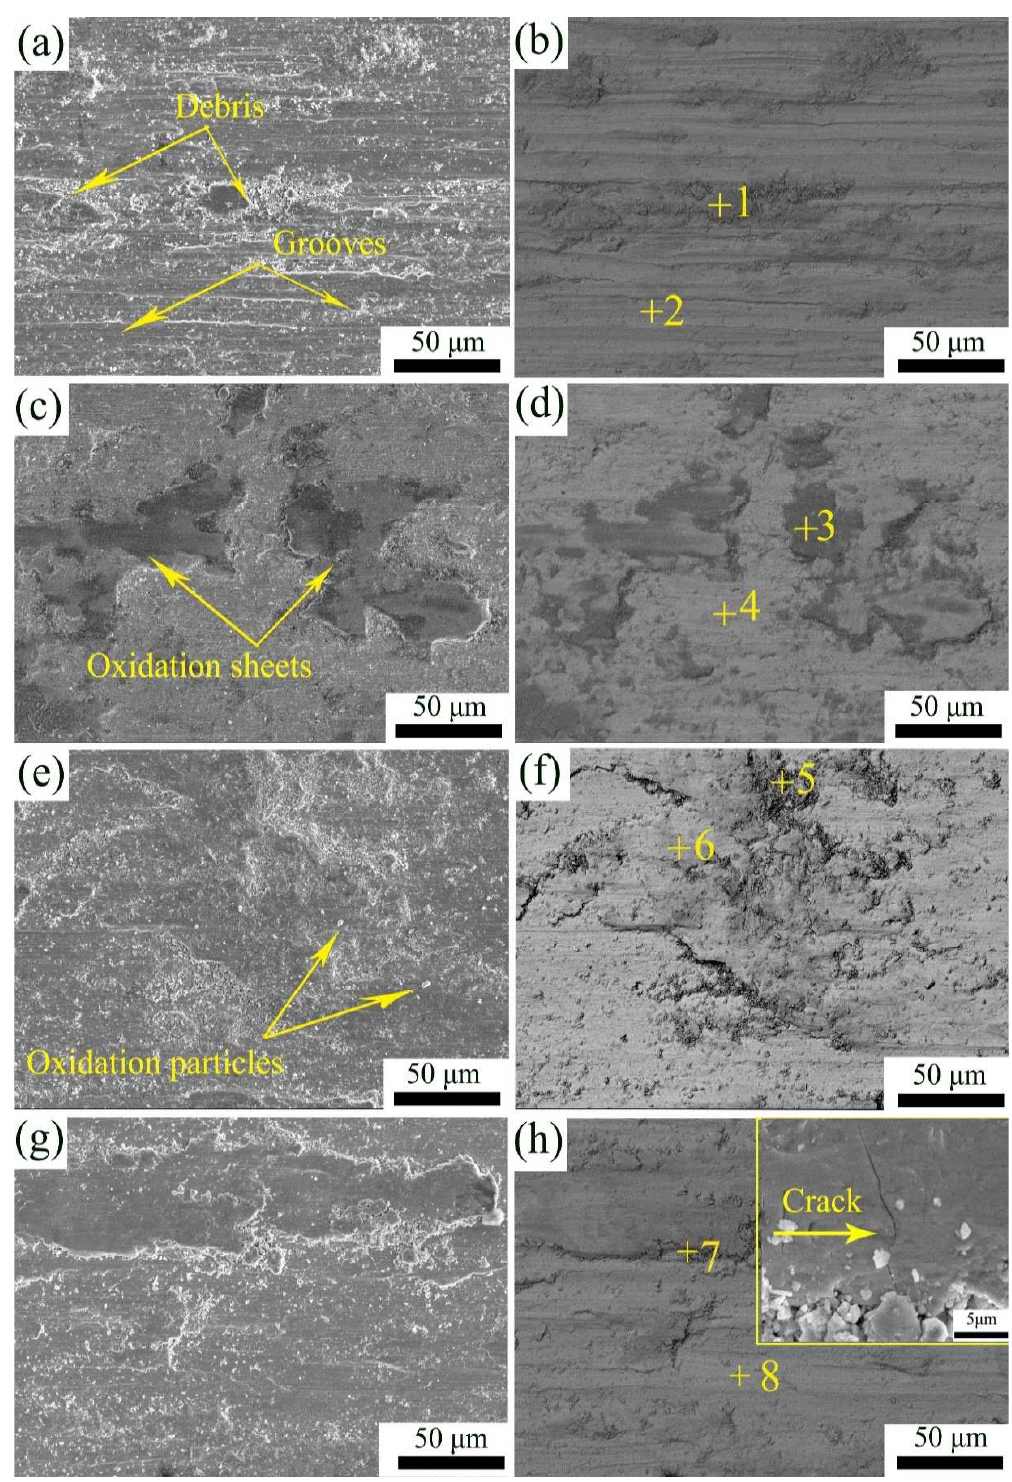
Figure 10. SEM images of worn surface morphologies of ( a ), ( b ) substrate (Ti6Al4V) and ( c ), ( d ) Al 0.5 , ( e ), ( f ) Al 1.0 and ( g ), ( h ) Al 1.5 subject to the dry-sliding reciprocating wear testing at room temperature in air (Si 3 N 4 as the counterparts, the 10 N load for 30 min, and the 3 mm/s sliding speed).